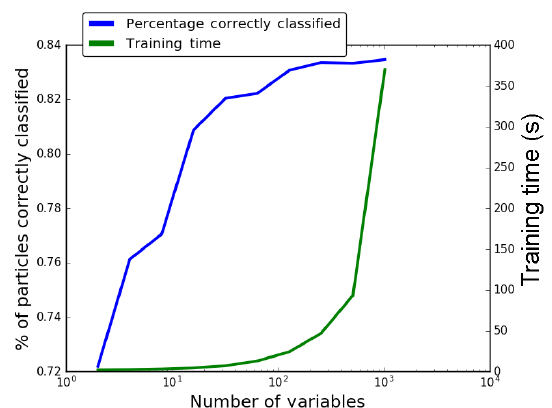
Figure 11. Variable importance for the different subsets of the data.